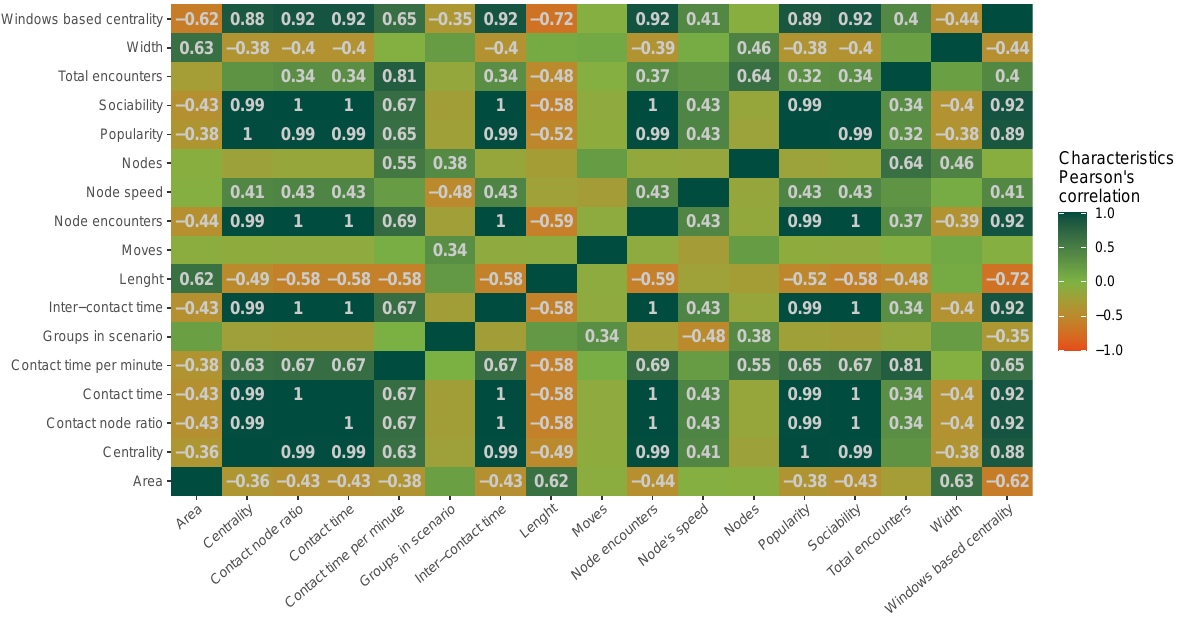
Figure 4. Heatmap of Pearson correlation coefficients between scenarios’ characteristics. Only significant Pearson’s correlation coefficients are